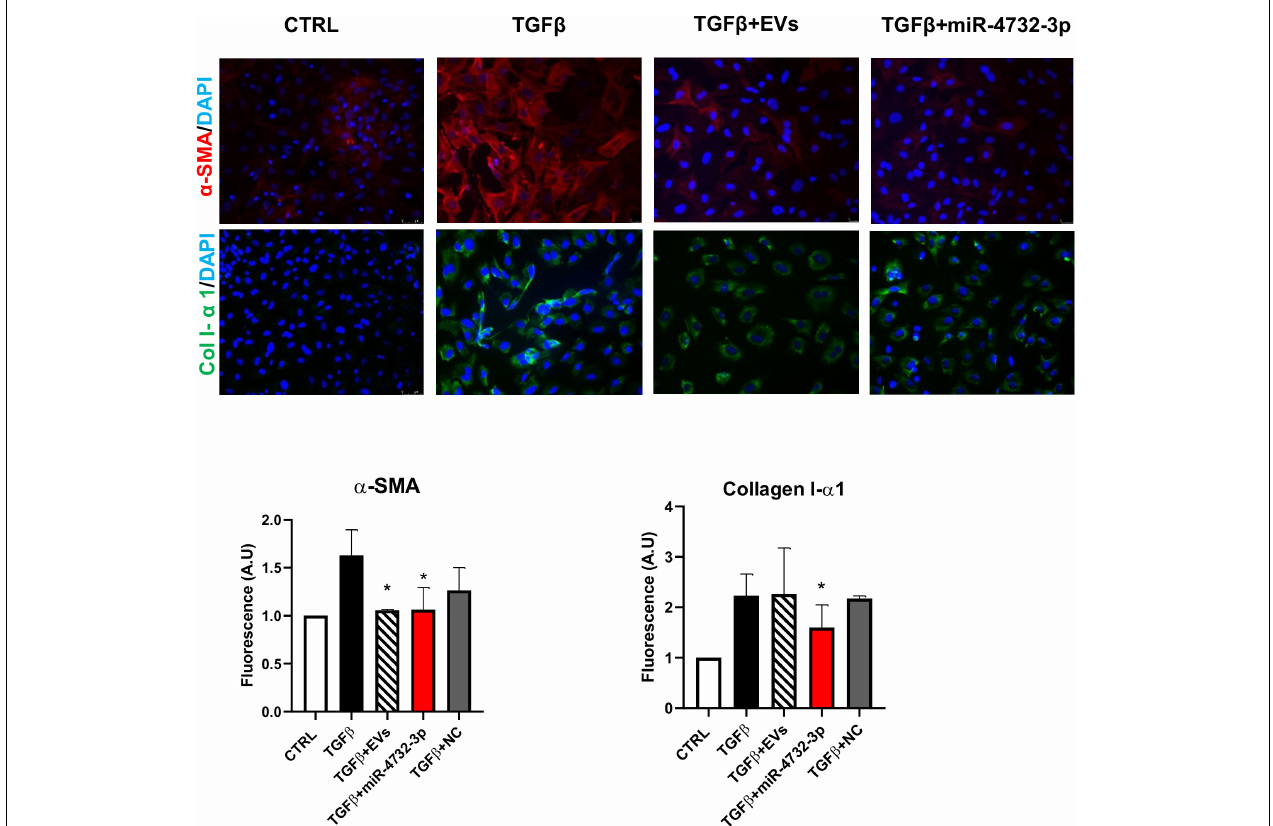
FIGURE 4 | Effect of EVs and miRNA 4732-3p on the expression of the myofibroblast markers α -smooth muscle actin ( α -SMA) and collagen 1 α (Col1). Fibroblasts were cultured in standard culture condition (CTRL) or treated with 10 ng/mL TGF β (TGF β ),with or without 30 µ g/mL of EVs (TGF β + EVs), 20 nM of lipofectamine-miR 4732-3p complexes or 20 nM of miR-Negative Control. Images were taken with a fluorescence microscope and the fluorescence was quantified using ImageJ ( n = 3, * p < 0.05).